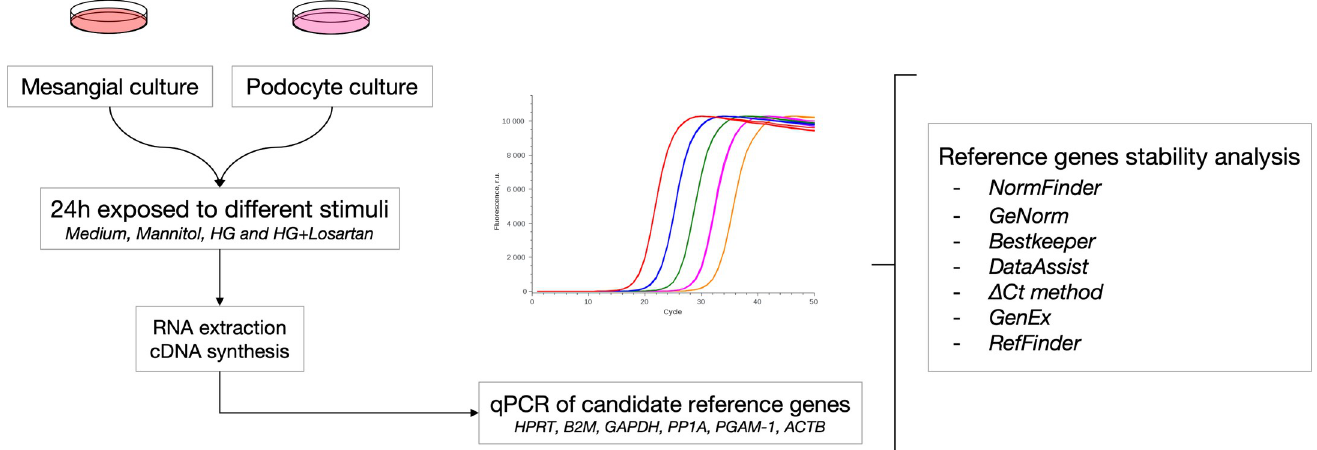
Fig 1. Study workflow. The figure shows the workflow for determination of the most stable reference gene for mesangial cells and podocytes exposed to mannitol, high glucose or high glucose and losartan. Five software packages (RefFinder, NormFinder, GeNorm, Bestkeeper, and DataAssist) and the comparative Δ Ct method were applied to analyze six different candidate genes: HPRT , ACTB , PGAM-1 , GAPDH , PPIA , and B2M . RNA was extracted, and cDNA was synthesized from immortalized mouse mesangial cells and podocytes cultured in 4 groups: control (n = 5; 5 mM glucose), mannitol (n = 5; 30 mM, as osmotic control), HG (n = 5; 30 mM glucose), and HG + losartan (n = 5; 30 mM glucose and 10 − 4 mM losartan).